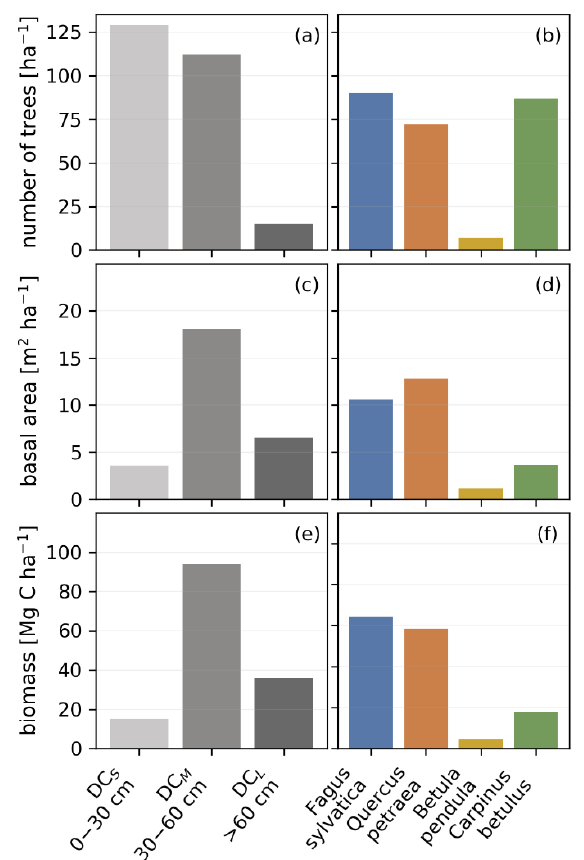
Figure 1. Forest inventory data from 2018. Stem numbers ( a , b ); frequency distribution of stem size classes, basal area ( c , d ) and biomass ( e , f ) at the 1-ha intensive research area of the Hohes Holz (DE-HoH) forest across three tree size classes ( left ) and occurring species ( right ).